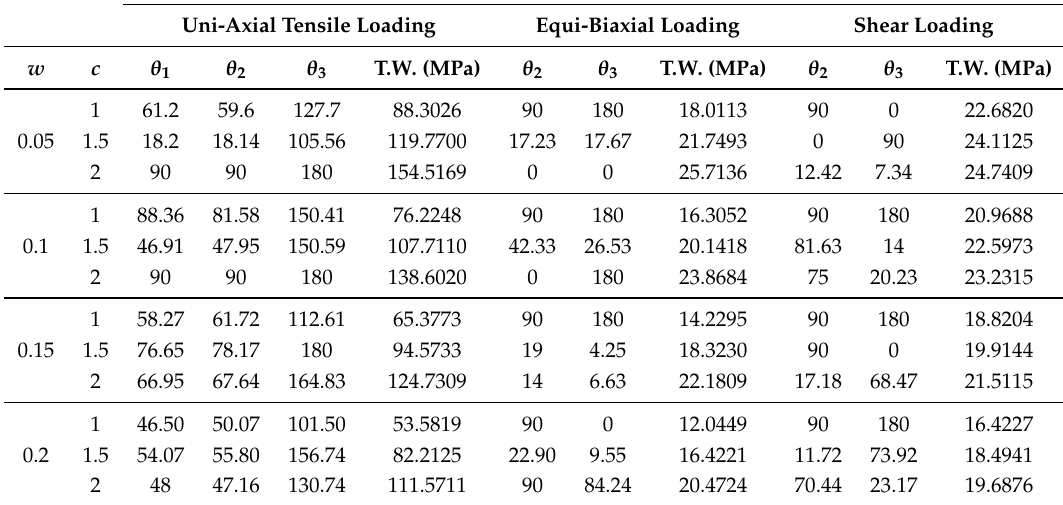
Table 10. The optimal values of design variables in different values of bluntness w and aspect ratio of quasi-triangular cutout c